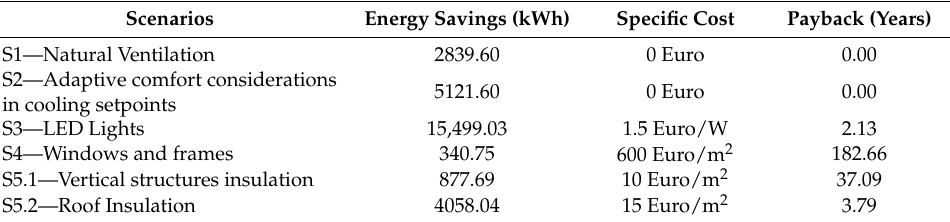
Table 2. Summary of the results for the retrofit solutions—economic